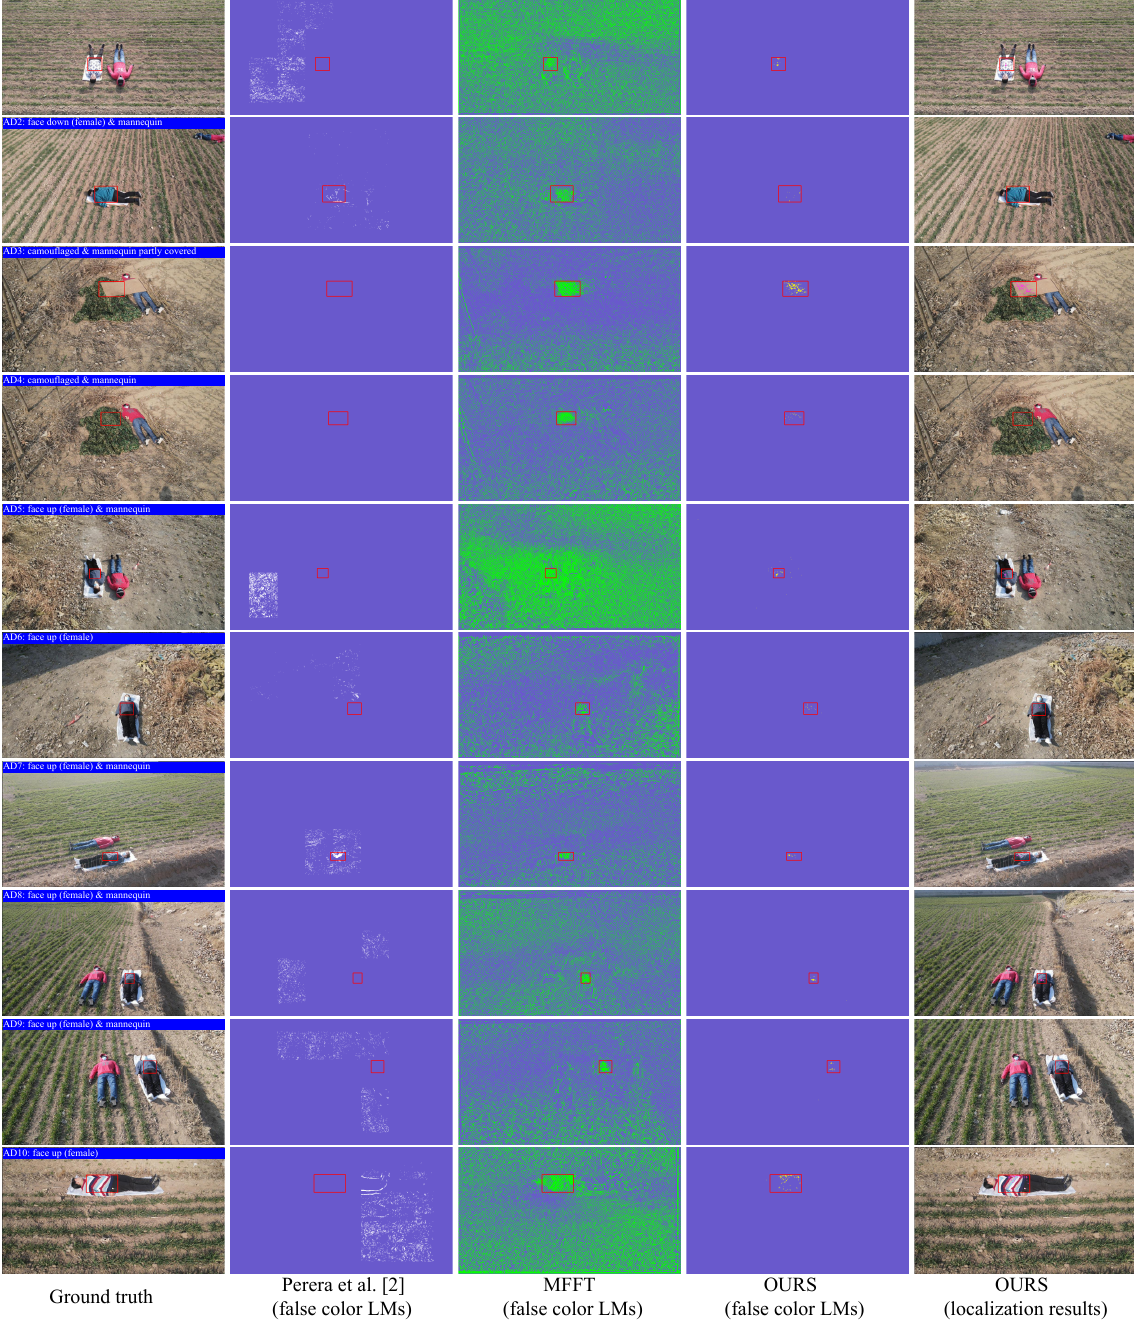
Figure A1. False color location maps (LMs) of Perera et al.’ work [2], MFFT and ours, and our localization results for ten drone videos (AD1 to